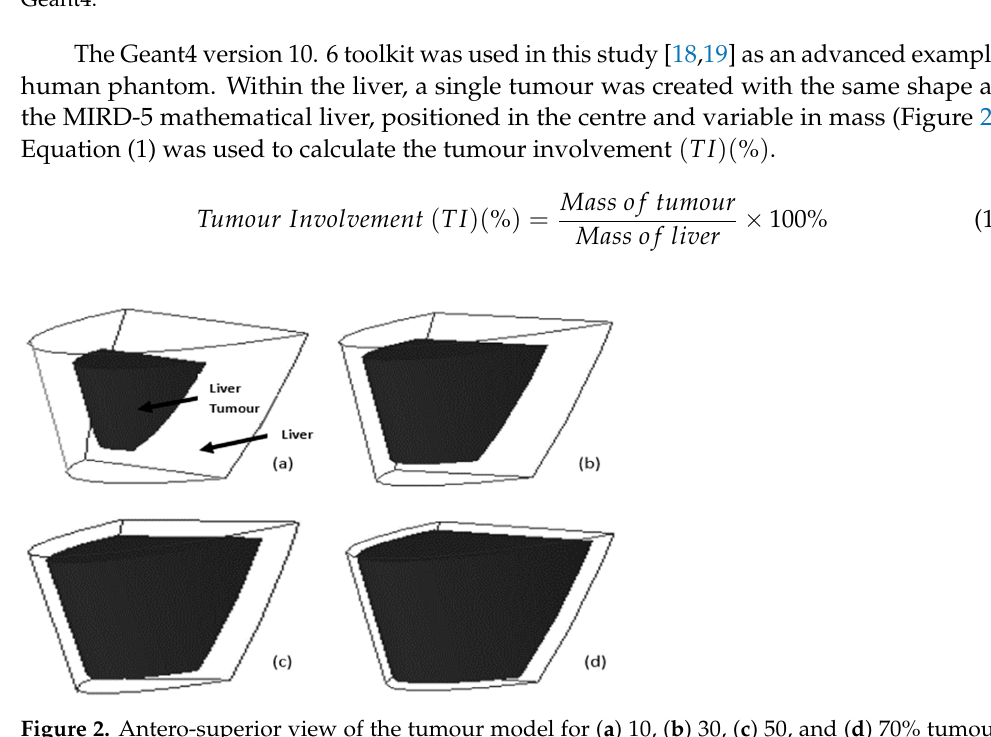
Figure 1. The MIRD-5 adult hermaphrodite human phantom as constructed and visualized using Figure 1. The MIRD ‐ 5 adult hermaphrodite human phantom as constructed and visualized using Geant4. Geant4.